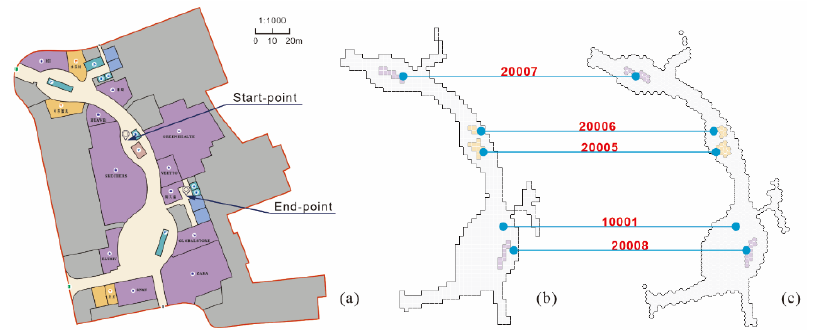
Figure 11. Experimental environment (EFC Live Plaza) ( a ) and its grid modeling diagram, ( b ) 2 m regular quadrilateral grid model, ( c ) 2 m regular hexagon grid model.